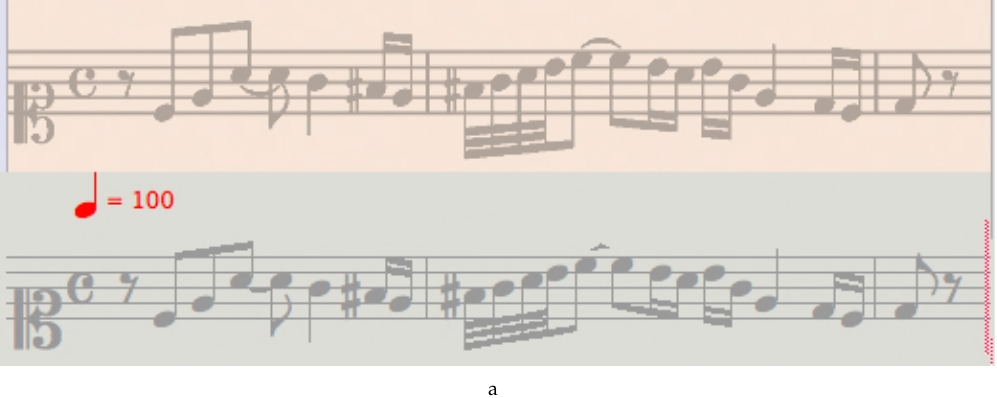
Figure 9. Incipit RISM ID no. 000051802. Einige canonische Veränderungen. Excerpts . Johann Sebastian Bach. Photoscore correctly recognizes the content, whereas our system fails. ( a ) Photoscore output: The sample is perfectly recognized; ( b ) Output of our system: The first tie is not detected.